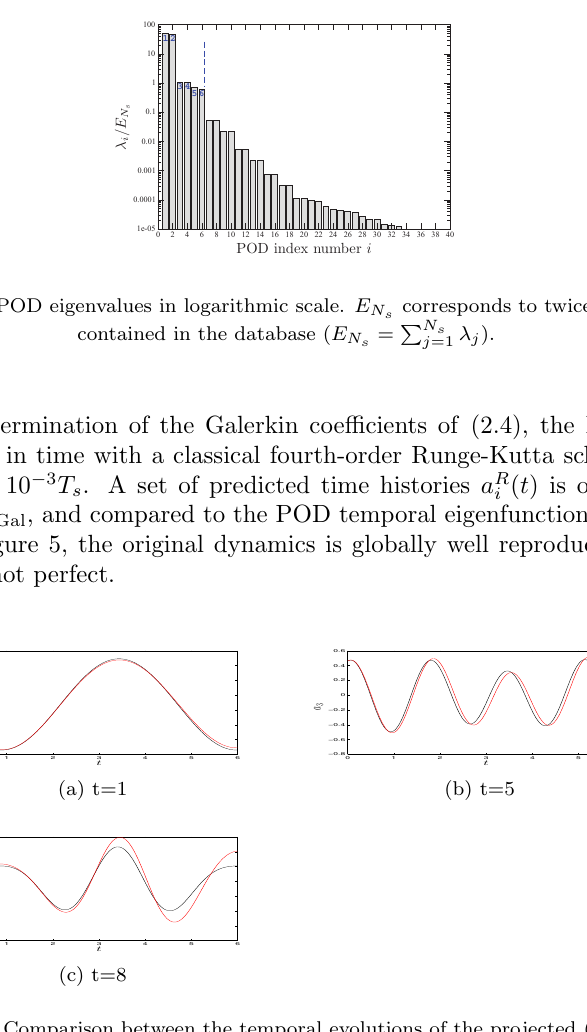
Figure 5. Comparison between the temporal evolutions of the projected (POD) and predicted (POD ROM) mode amplitudes when the Galerkin coefficients are used for integrating the POD